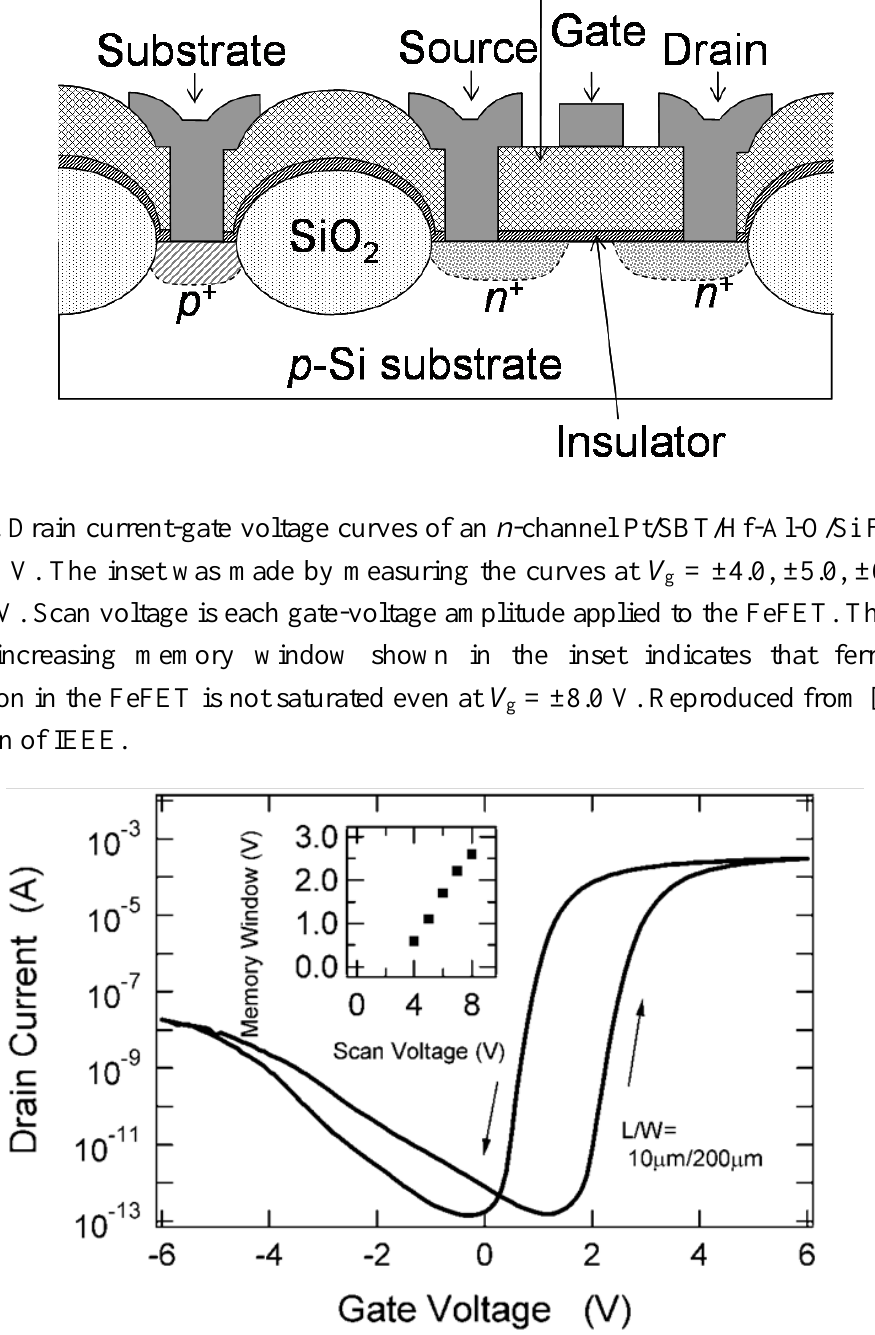
Figure 1. Schematic cross section of a fabricated FeFET. Gate, ferroelectric and insulator are made of Pt, SBT and Hf-Al-O, respectively. Reprinted from [17] with permission of the Japan Society of Applied Physics.